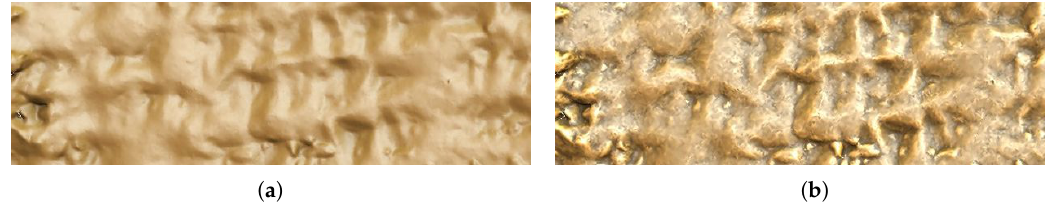
Figure 9. Section with subtle features on fragment E219 without ( a ) and with radiance scaling ( b